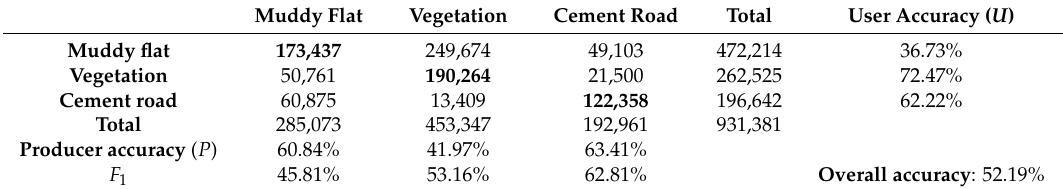
Table 6. Confusion matrix of classification by incidence angle-corrected intensity data.